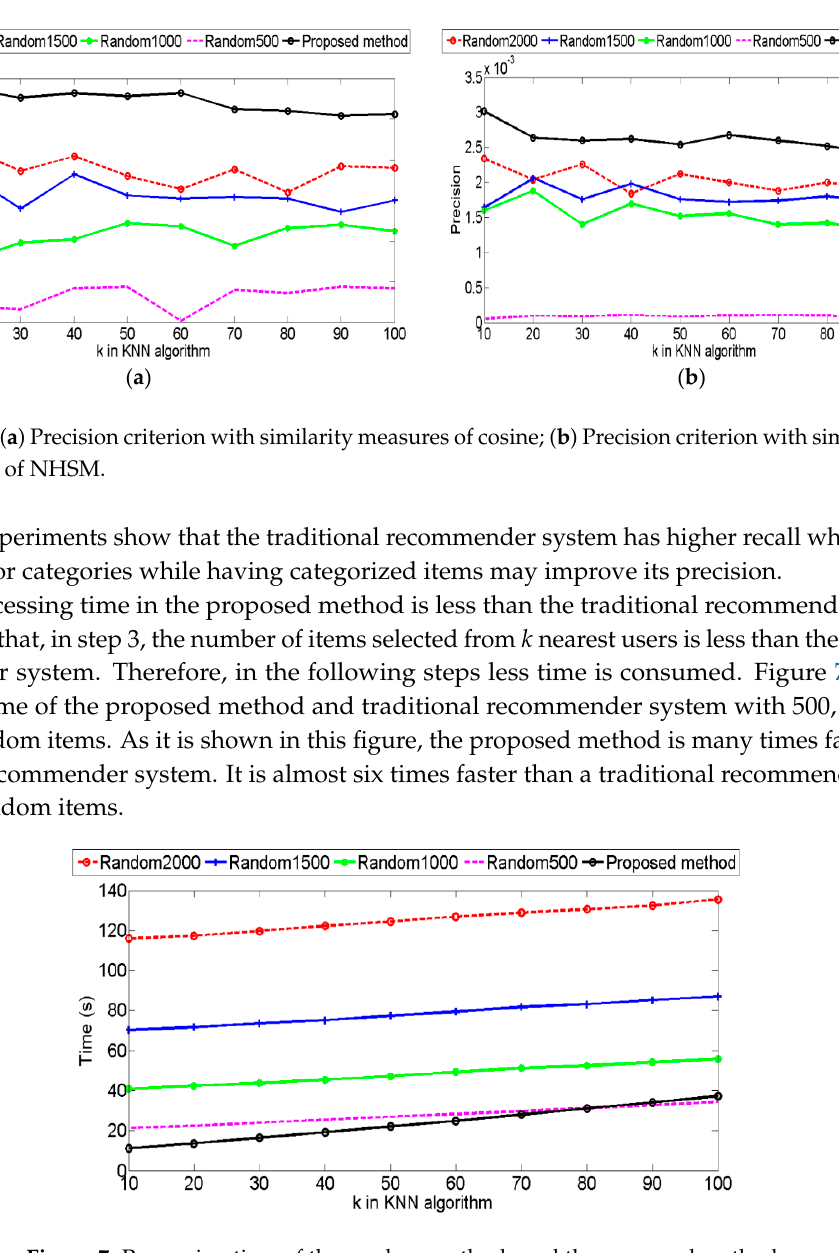
Figure 7. Processing time of the random methods and the proposed method.